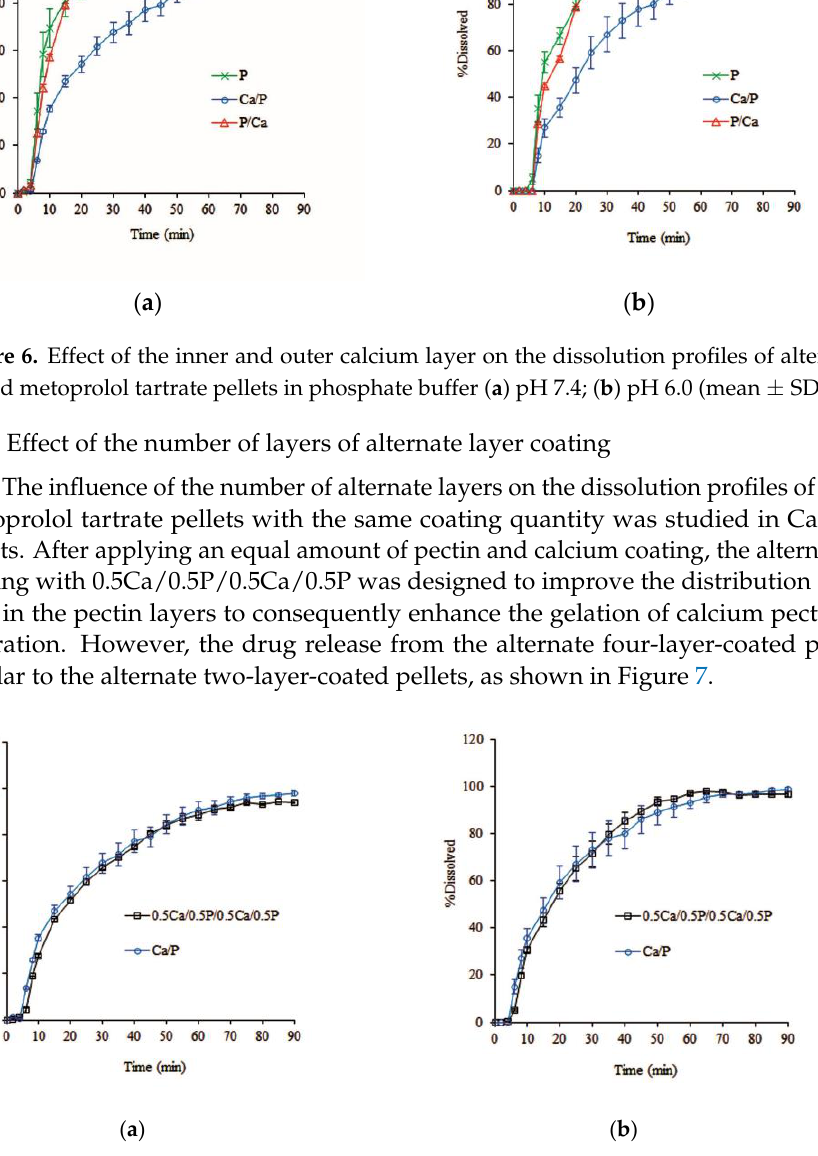
Figure 7. Effect of the number of layers on the dissolution profiles of alternate-layer-coated metoprolol tartrate pellets in phosphate buffer ( a ) pH 7.4; ( b ) pH 6.0 (mean ± SD; n = 3).